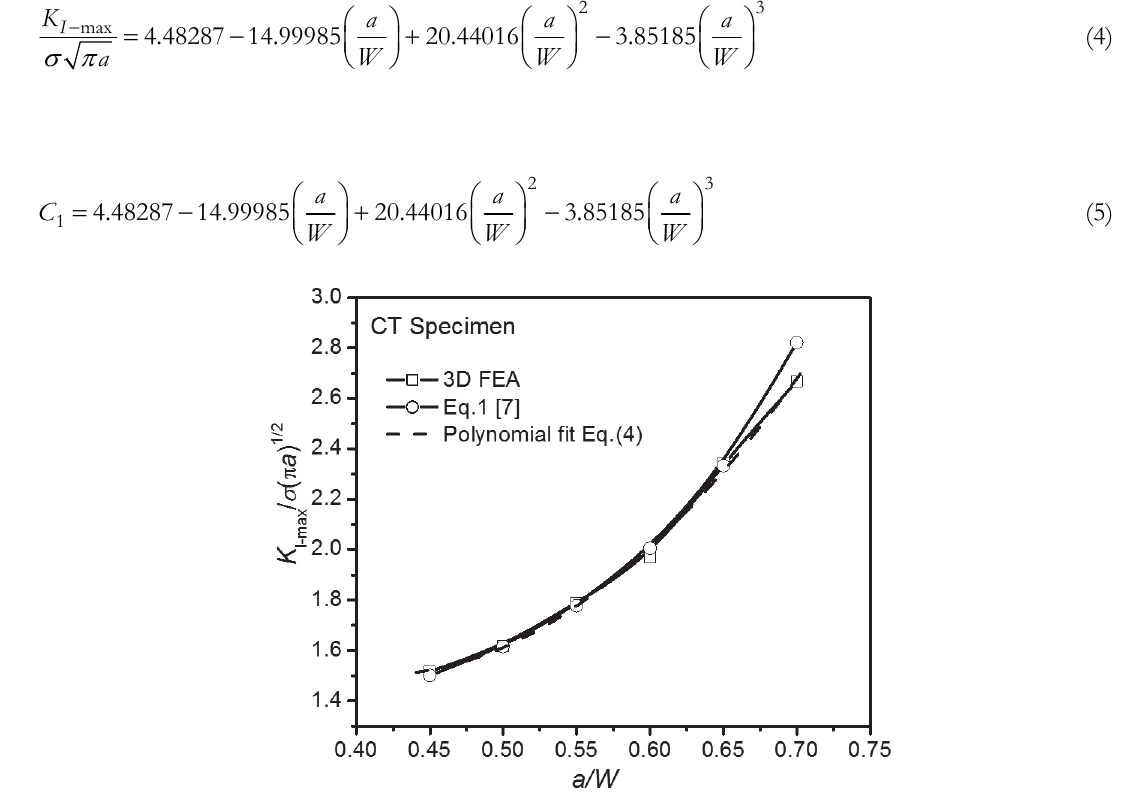
Figure 4: Variation of slopes, K I-max /   a 1/2   vs.